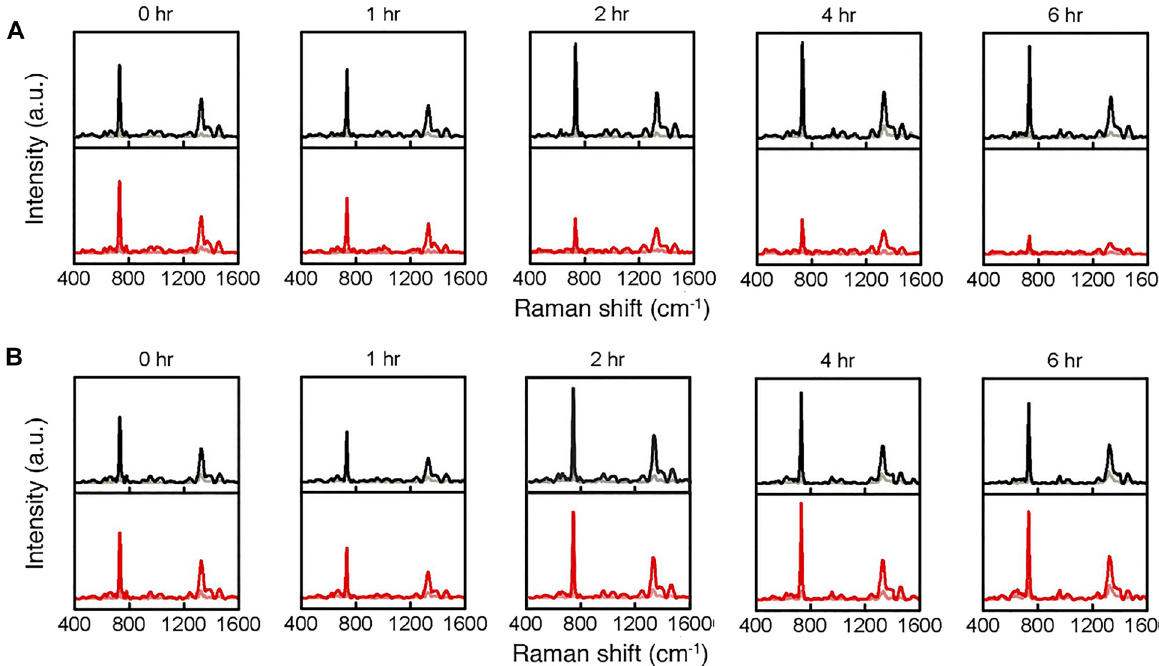
Figure 4: Time-lapse surface enhanced Raman scattering (SERS) spectra for methicillin-susceptible and -resistant S. aureus (MSSA and MRSA) with and without oxacillin treatment. (A) S. aureus (MSSA, ATCC 29213); (B) clinical isolate of MRSA with (red curves) and without (black curves) oxacilin treatment; Black and red curves represent the mean SERS spectra, while gray and light red curves represent their corresponding standard deviation. A HeNe laser emitting at 632.8 nm served as the excitation source